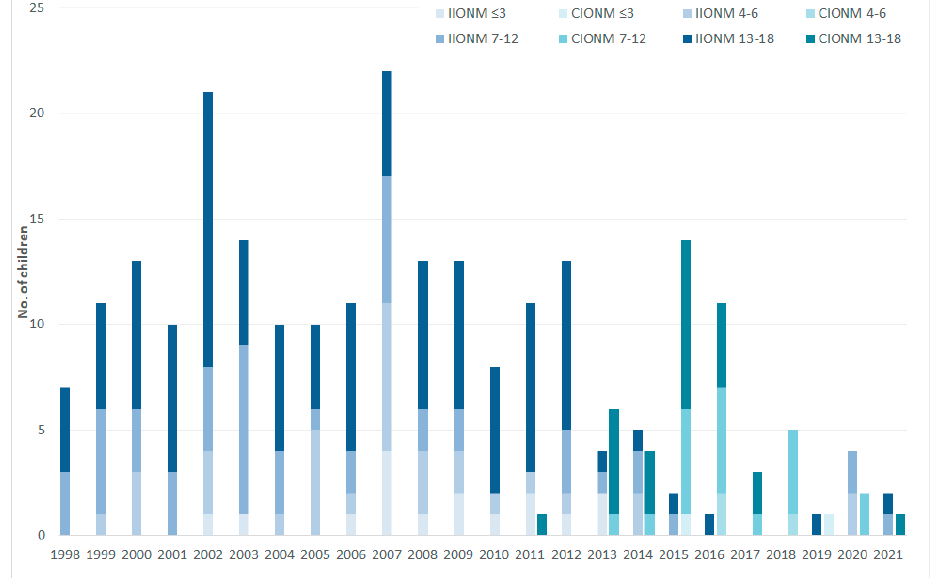
Figure 1. Age distribution of thyroid surgery per year by intermittent vs. continuous neuromonitoring (IIONM vs. CIONM), January 1998–April 2021. Table 2. Demographics, thyroid histopathology, extent, type, and completeness of pediatric oncological thyroidectomy by type of recording electrodes.